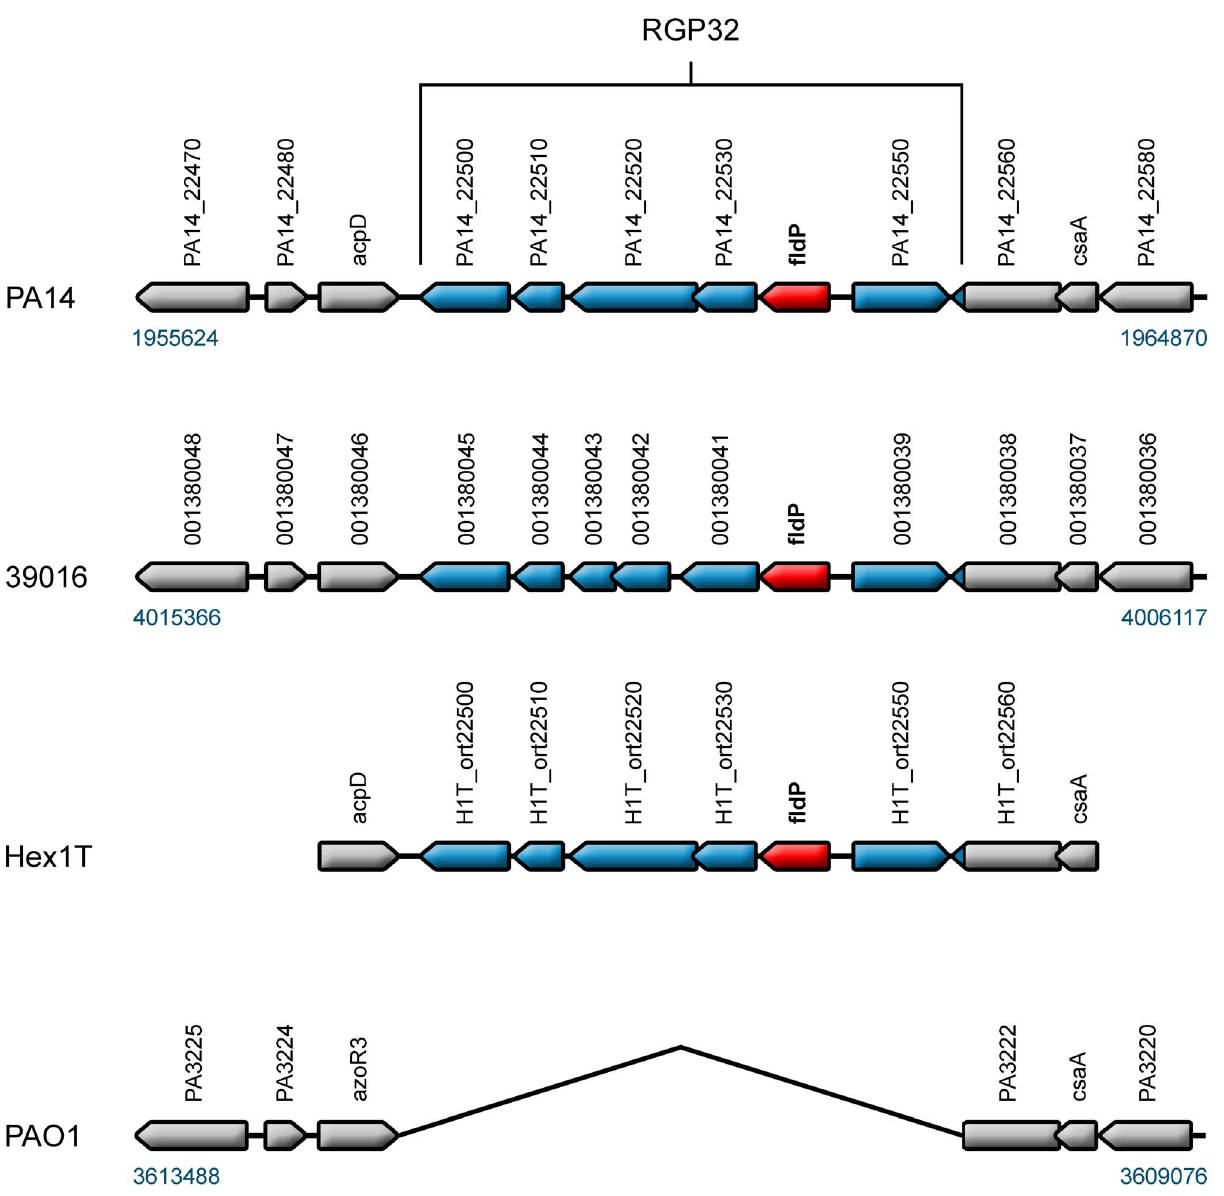
Figure 8. fldP is a component of the P.aeruginosa variable genome. The fldP gene (in red) is located in a cluster of six genes which is referred to as RGP32 [33], here represented in blue in strains PA14, 39016 and Hex1T. The genomic context of RGP32 was outlined in gray in the three strains and also in the prototypic strain PAO1, which does not harbor RGP32.